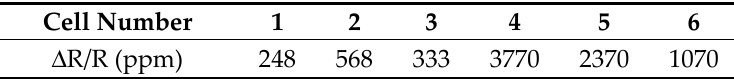
Table 1. Piezoresistor shift after aging 14 days at 250 °C for 6 different